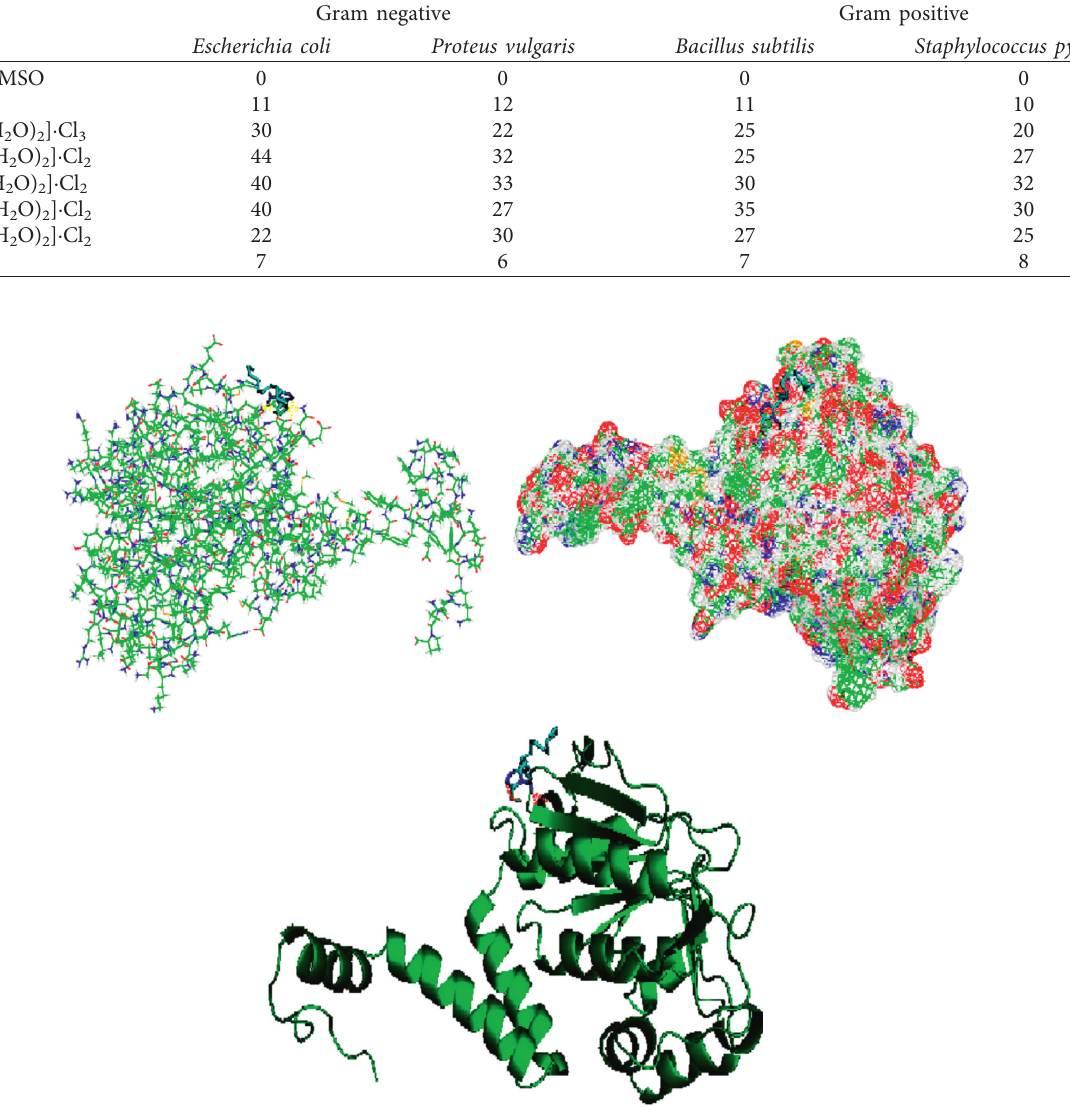
Figure 6: Three-dimensional plot of interaction of triazole ligand with E. coli (3 t88)